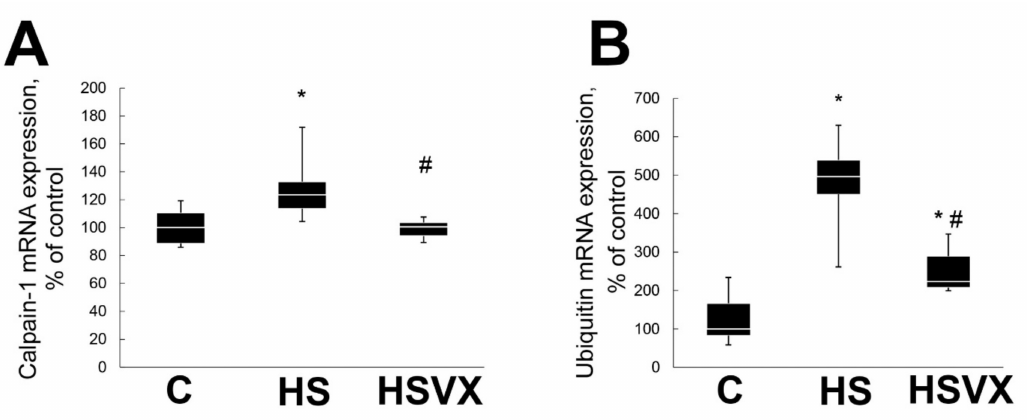
Figure 3. Evaluation of mRNA expression of calpain-1 ( A ) and ubiquitin ( B ) in soleus muscles of C, HS, and HSVX rats. Values are normalized to the level of GAPDH mRNA expression in each sample. n = 8. * indicates a significant di ff erence from the control, p < 0.05; # indicates a significant di ff erence from the HS, p < 0.05.